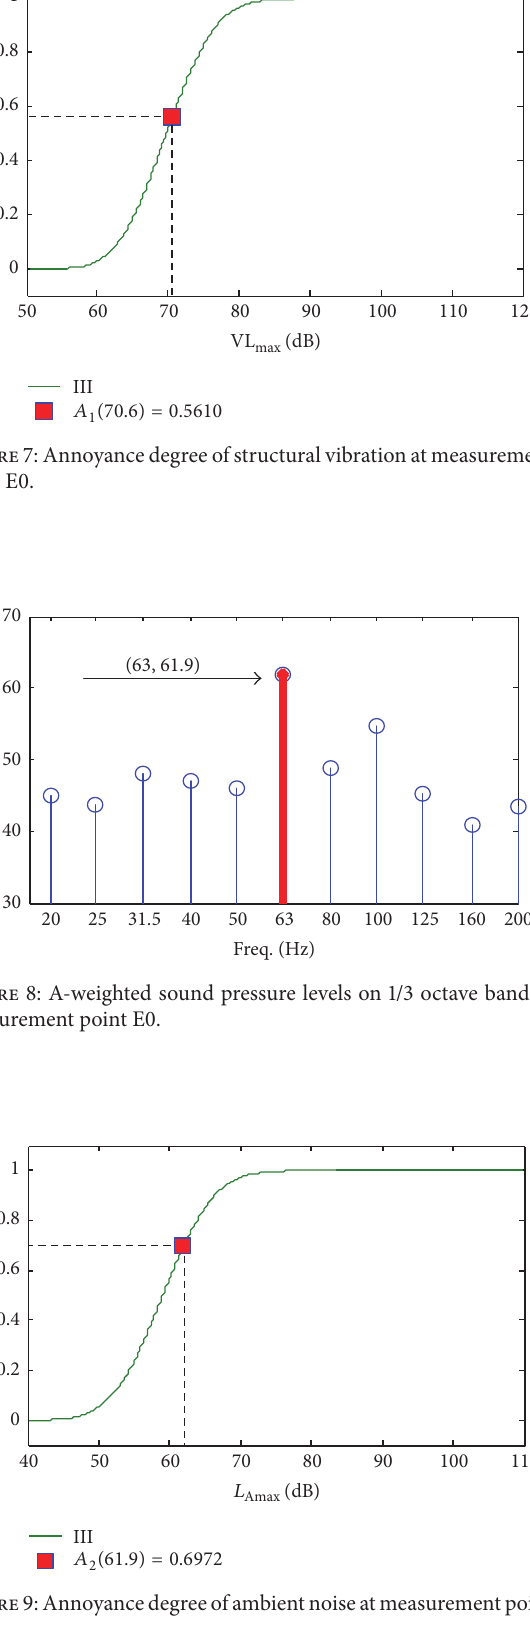
Figure9:Annoyancedegreeofambientnoiseatmeasurementpoint